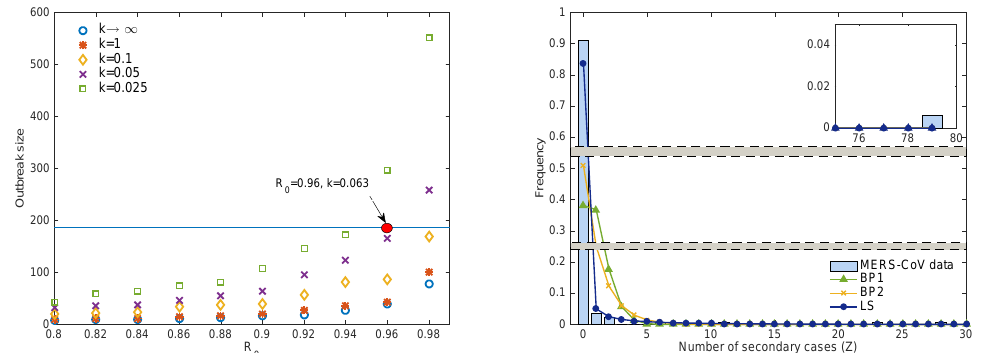
Figure 7. Outbreak size for several R 0 and k . Each result is the mean of 5000 simulations. The blue line indicates 186 patients of MERS-CoV in South Korea (left), 2015 MERS-CoV data (bar), and the results of the three models with parameters of best-fitting (red filled circle; k = 0.063 and R 0 = 0.96 with 167